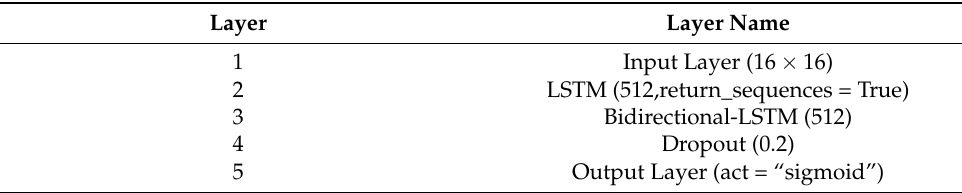
Table 2. Structure of the proposed RNN